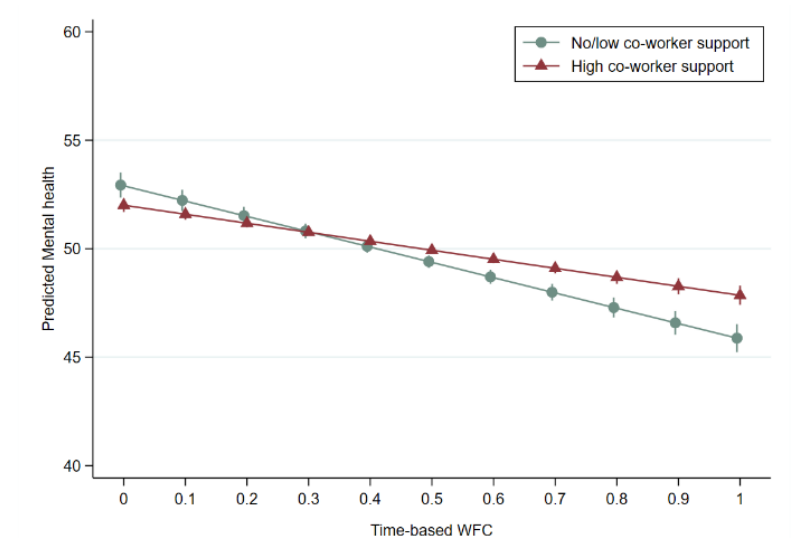
Note: Interaction plot based on linear fixed-effects regressions with interaction terms and predicted margins; p <0.001; N = 4,920. WFC = work-to-family conflicts. Controlled for controlled for age, actual working hours, physical strain, hourly wages, age of youngest child in household. LEEP-B3 Survey, own